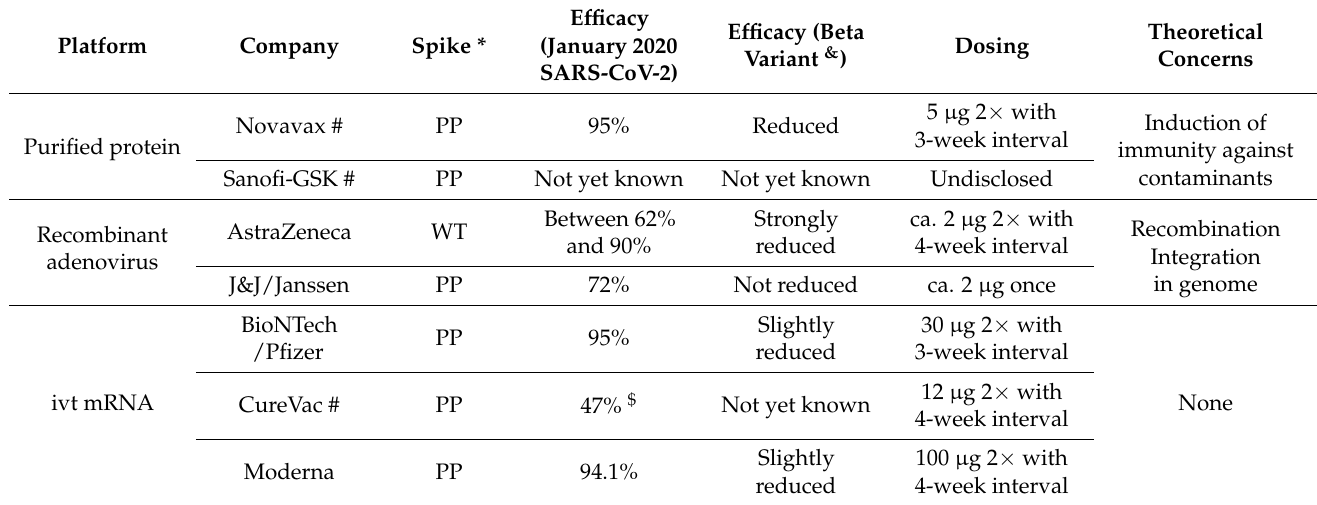
Table 2. Vaccines against COVID-19 chiefly ordered by Westernized